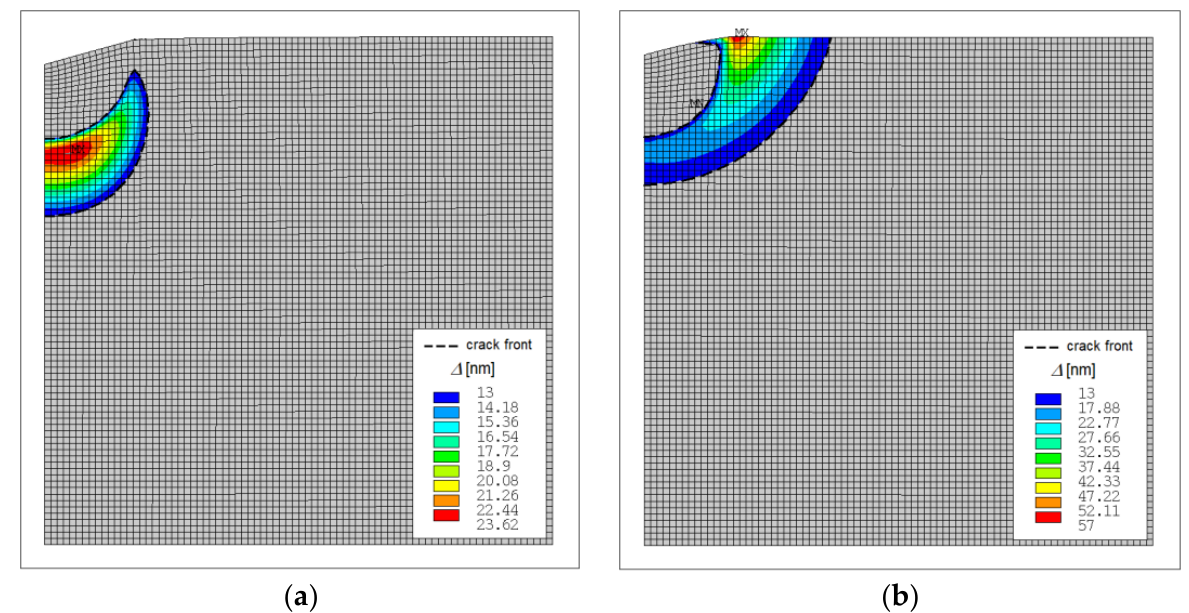
Figure 10. Distribution of the crack opening ∆ along the crack flanks for P max = 300 mN ( a ) maximal loading, ( b ) complete unloading.